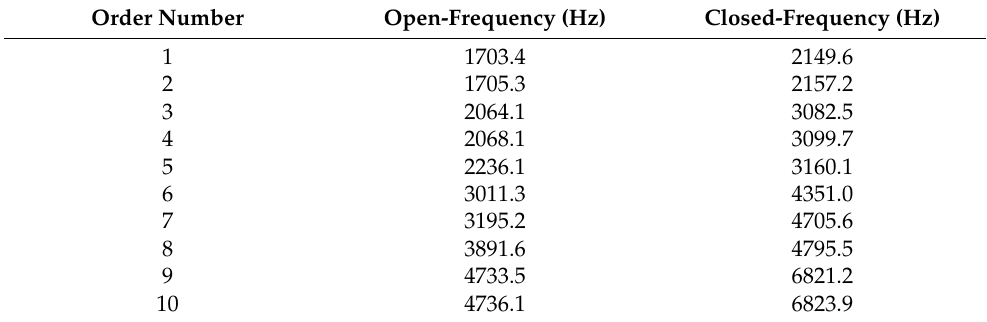
Figure 4. Modal analysis results. Table 3. Modal analysis